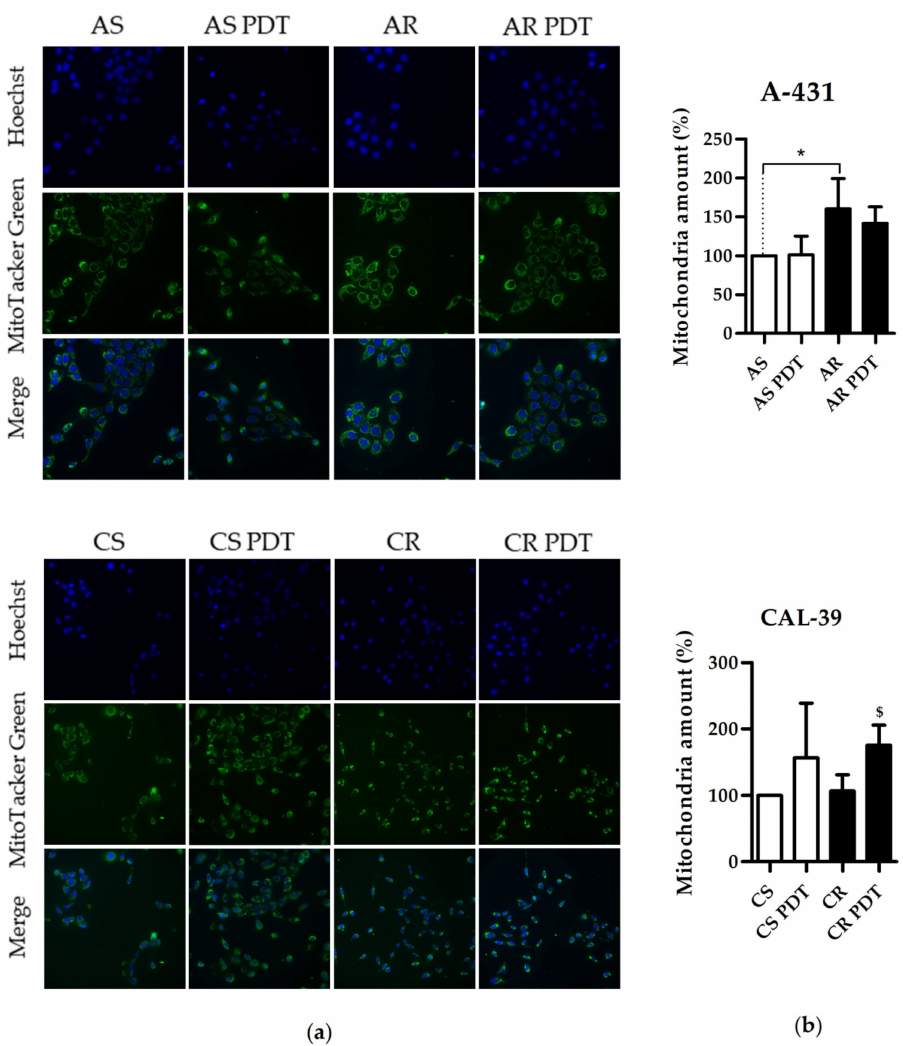
Figure 7. Comparison of the number of mitochondria. ( a ) Images of stained cells before and after treatment. Pictures were taken by the use of Olympus ScanR fluorescence microscope with 20 × objective. ( b ) Graphs showing results as percentage of mean corrected total cell fluorescence (CTCF) value of untreated parental cells. Statistical significance between sensitive and resistant cells (* p ≤ 0.05) or between untreated and treated resistant cells ( $ p ≤ 0.05) were calculated via Mann-Whitney